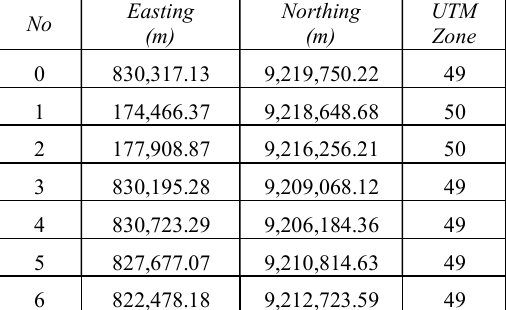
Figure 5. Histogram of Waveheight